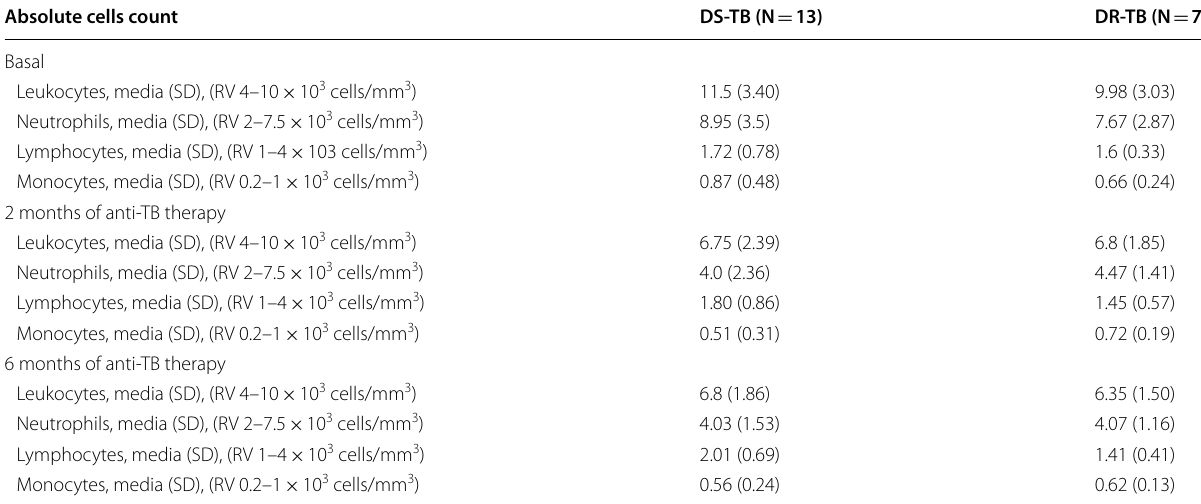
Table 2 Absolute cells count in peripheral blood at basal, 2 m and 6 m of anti‑TB therapy